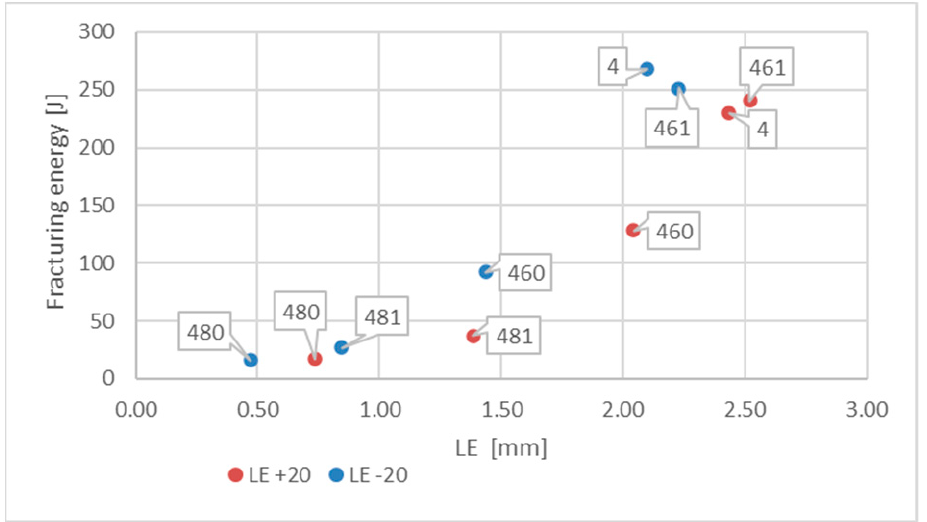
Figure 25. Relationship between averaged values of LE parameter and related values of fracturing energy obtained for X2CrNiMoN22-5-3 steel at di ff erent testing conditions.